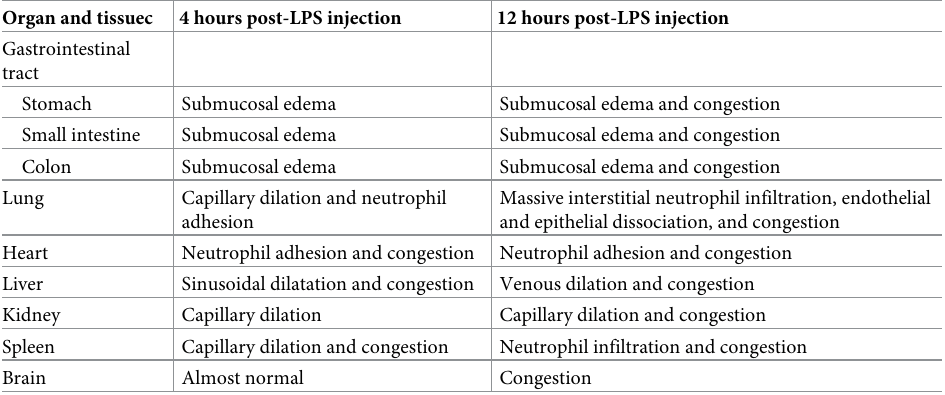
Table 2. Summary of the histological findings in wild-type mice after LPS injection.